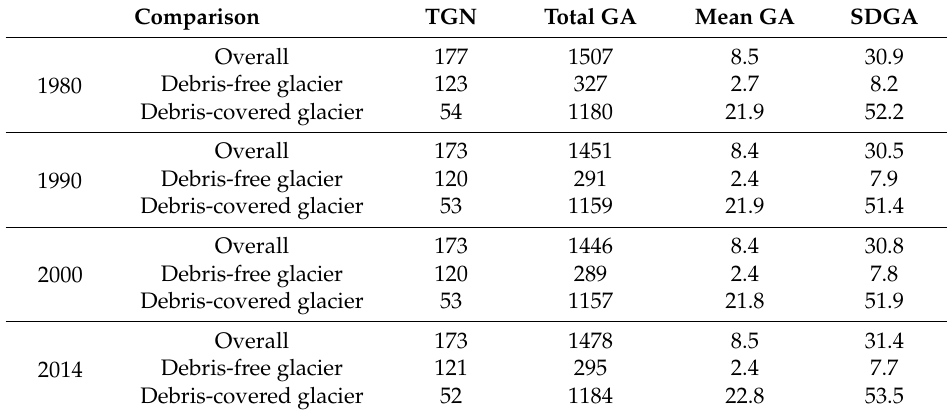
Figure 10. Glacier area change rate during 1970–1980 ( a ), 1980–1990 ( b ), 1990–2000 ( c ) and 2000–2014 ( d ) periods (( − ): decreased in area, ( + ): increased in area).